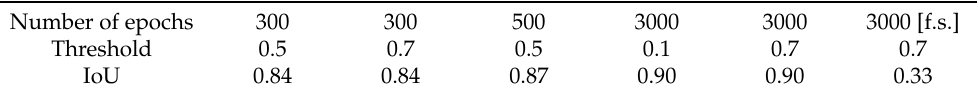
Table 2. Performance metrics of the segmentation process for a specific hieroglyph (“owl”), vs. the training epochs and objectness score threshold ([f.s.] refers to the training from a scratch case). Number of epochs 300 300 500